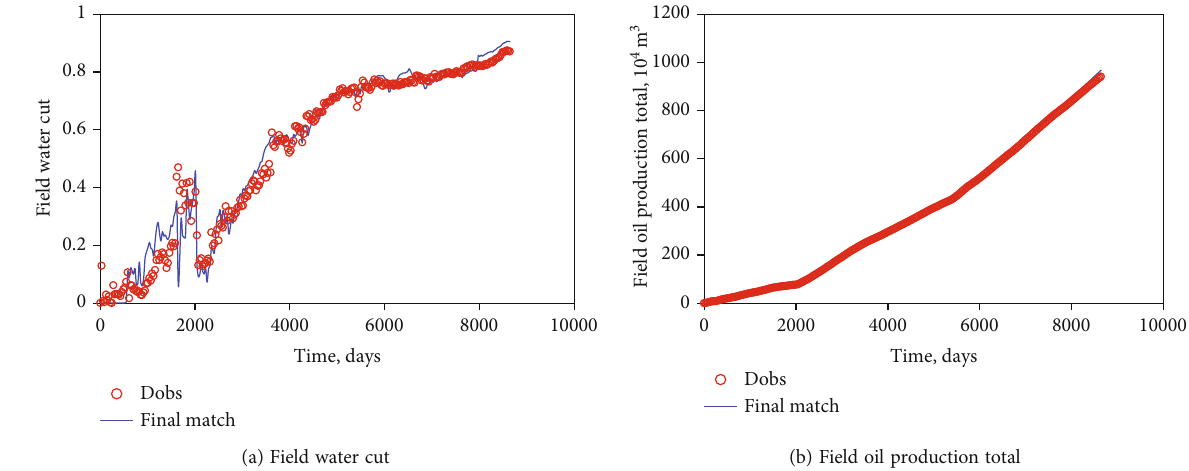
Figure 16: History matching results.